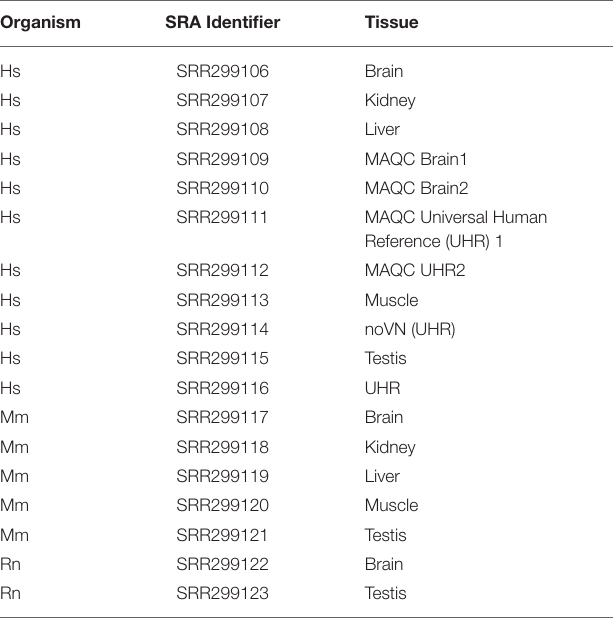
TABLE 2 | SRA polyA-Seq data utilized from Derti et al. (2012).